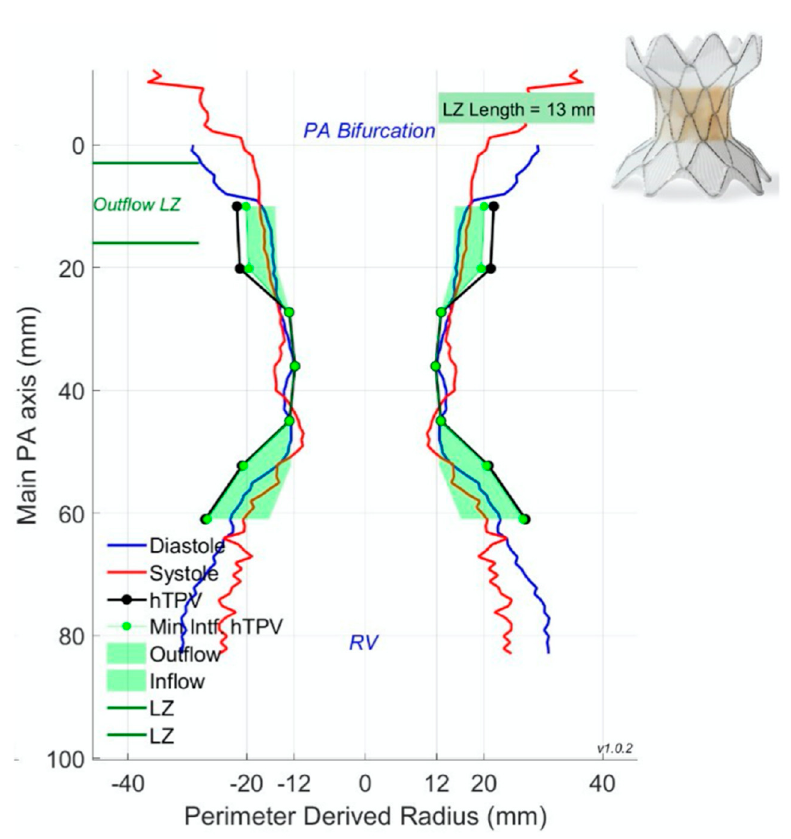
Figure 11. Perimeter plot represents optimal valve placement of the 25 mm Harmony valve (Medtronic, Minneapolis, MN) shown on the top right of the figure. The outflow landing zone (LZ) on the pulmonary artery (PA) end is a landmark for implanters to deliver the distal end of the Harmony valve. Furthermore, blue (diastole) and red (systole) lines depict the variation in cardiac dimensions during cardiac motion for better predictions of valve placement.